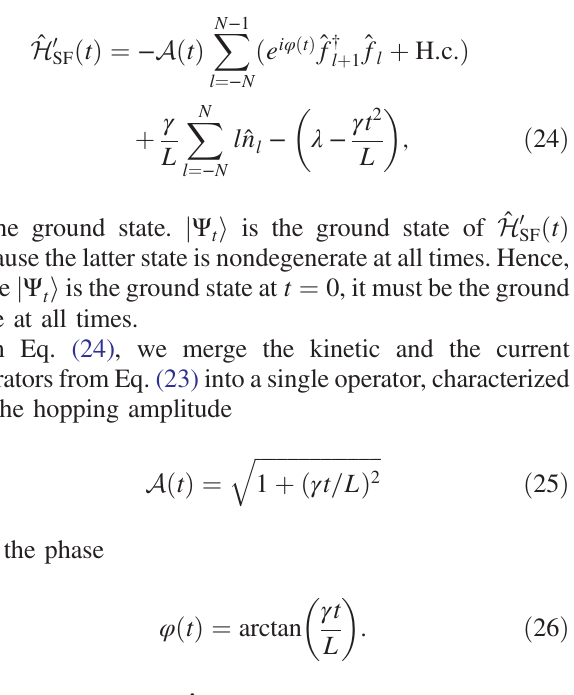
FIG. 1. Times of validity of the emergent eigenstate description. (a) Subtracted overlap j 1 − O ð t Þj , where O ð t Þ ¼ jh Ψ t j ψ ð t Þij ,